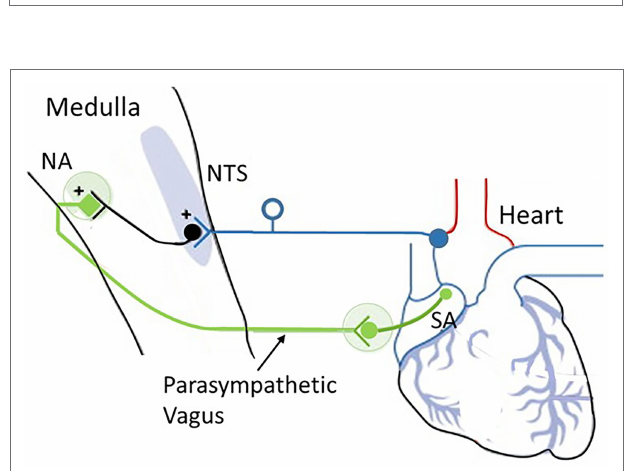
FIGURE 6 | The cardioinhibitory baroreflex (vagally mediated cardiac bradycardia) . Baroreceptor afferents (dark blue) synapse at the nucleus of the tractus solitarius (NTS). The vagal component of the baroreflex (green) runs from the NTS to the nucleus ambiguus (NA) and sends efferents to the sinoatrial node (SA) to regulate heart rate. Source: Low and Tomalia (2015). Reproduced under the terms of Creative Commons Attribution Non-Commercial License (http:// creativecommons.org/licenses/by-nc/3.0/).